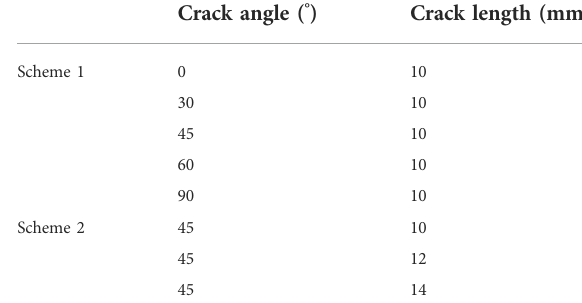
TABLE 1 Calculation